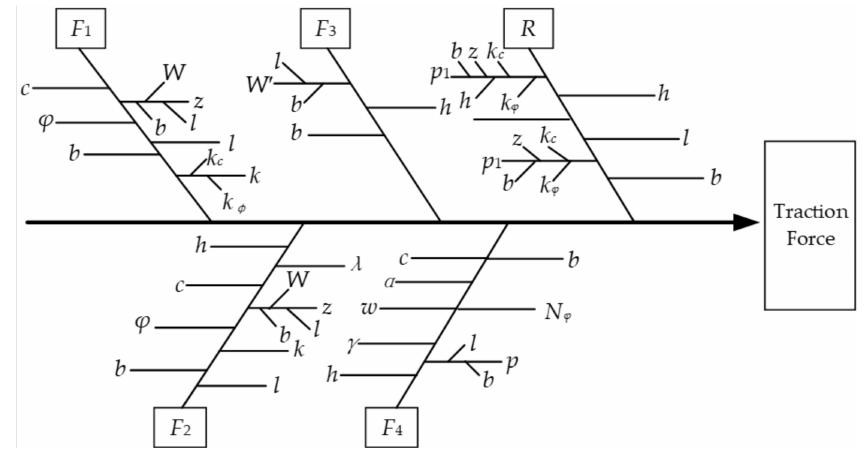
Figure 8. Causal analysis diagram of the traction